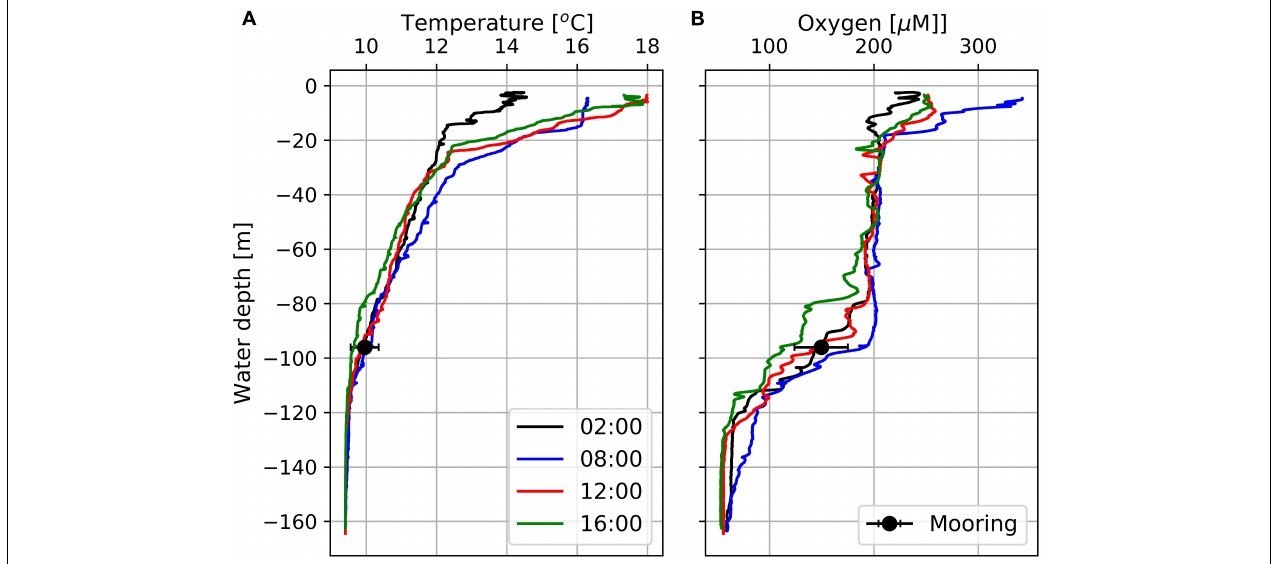
FIGURE 5 | Temperature (A) and dissolved oxygen (B) profiles at Station 7 ( Figure 1 ) obtained at four different times between February 18th and 19th, 2019. Black circles indicate daily mean temperatures and oxygen concentrations including standard deviations as derived from data measured by the deployed MDO sensor at a water depth of 96 m the day after the CTD casts.